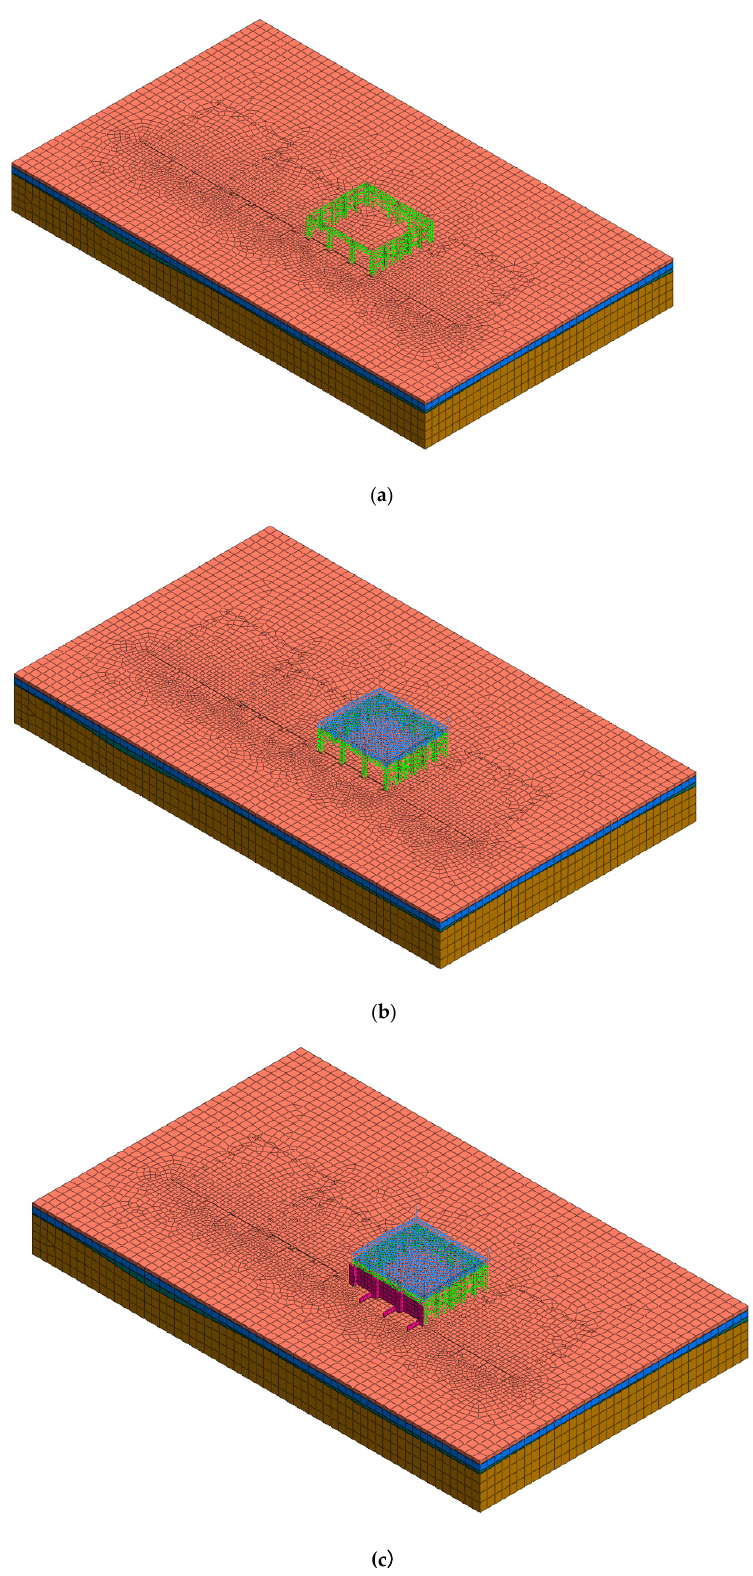
Figure 11. Numerical analysis of converter station steel structure: ( a ) beam and column construction of converter station steel structure, ( b ) hoisting of converter station steel structure, and ( c ) firewall construction.